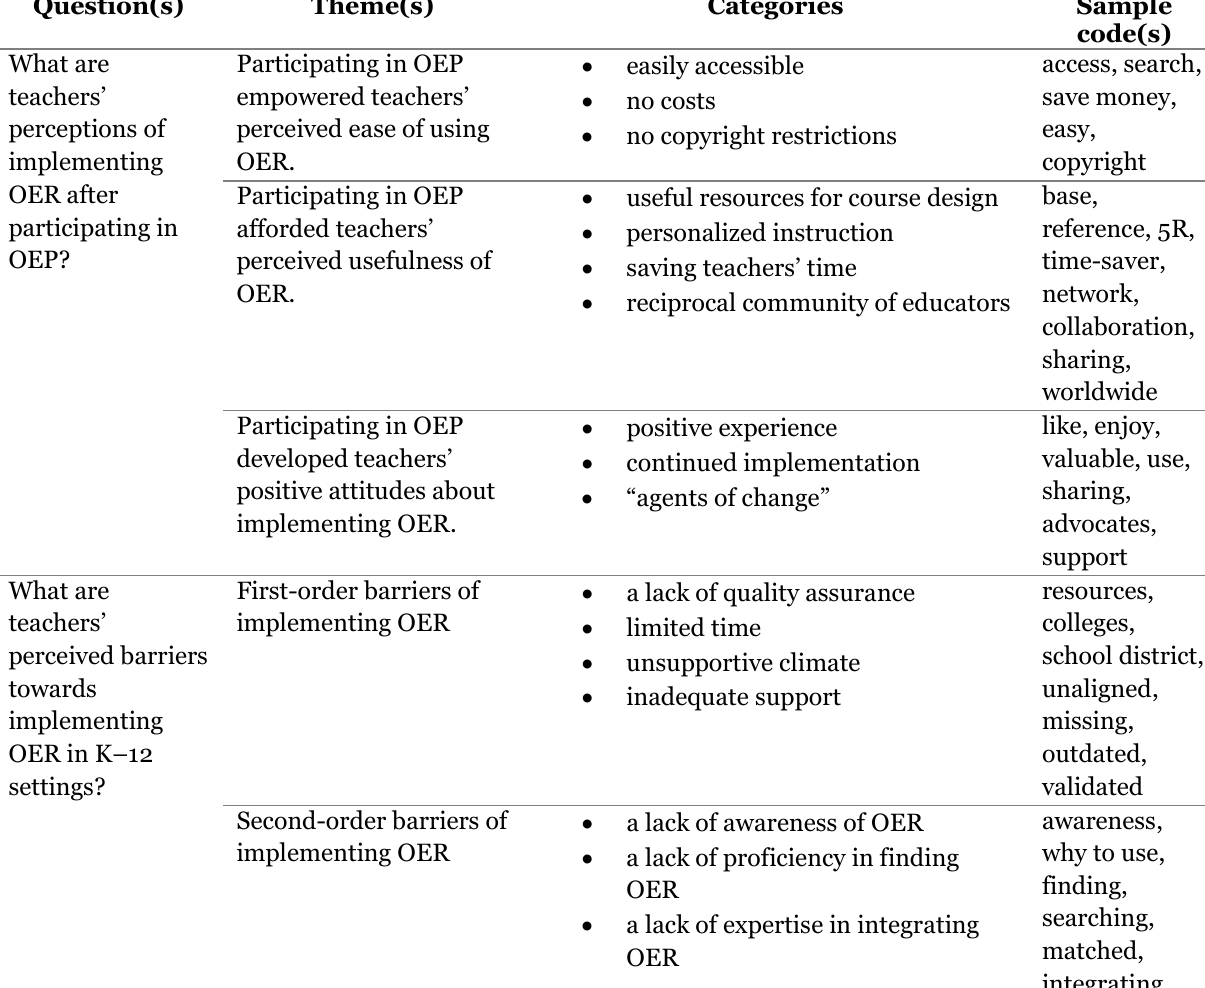
Summary of the Qualitative Data Analysis